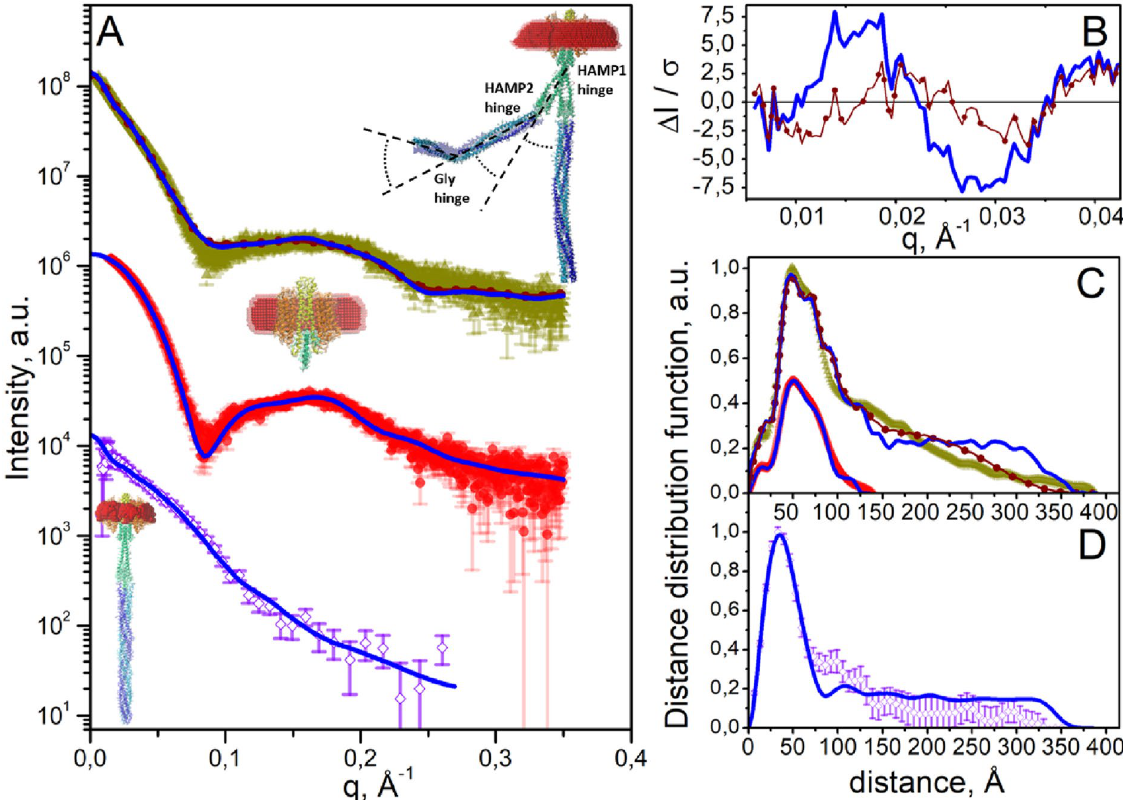
Figure 2. Dimerization of Np SRII/ Np HtrII 137 and of full-length Np SRII/ Np HtrII at low salt concentration. ( A ) Bottom—experimental SANS curve for Np SRII/ Np HtrII (purple hollow rhombus) and CRYSON fit ( χ 2 = 0.7, corresponding blue line) based on a model (shown on the left of the curves) of an Np SRII/ Np HtrII dimer with a detergent corona. Middle—experimental SAXS curve for the Np SRII/ Np HtrII 137 dimer (red circles) and MEMPROT fit ( χ 2 = 1.5, corresponding blue line) based on a model (shown near the corresponding curve) of the Np SRII/ Np HtrII 137 dimer with the detergent corona. Top—experimental SAXS curve for full-length Np SRII/ Np HtrII (dark yellow triangles) and two theoretical approximations. The first (blue solid line) is a CRYSOL3 fit ( χ 2 = 5.1) based on a "straight" model of the Np SRII/ Np HtrII dimer. The second (brown pointed line) is a fit ( χ 2 = 3.4) based on a combination of modified models of the Np SRII/ Np HtrII dimer (see “Methods”, Fig. S2 and Text document S1 for details). While the difference between the two fits is not immediately apparent, the improved fit of the second approximation is evident when considering of the relative residuals of the fit in the region in reciprocal space q < 0.04 Å −1 (see B ), that corresponds to the distances > 160 Å in a real space. For this range of distances, discrepancy between the experimental distance distribution function and theoretical one obtained for the "straight" model of the Np SRII/ Np HtrII dimer is evident (see C ). In the representations of the atomic models, the detergent belt is shown in red. ( B ) Relative residuals of theoretical approximations and experimental SAXS data obtained for full-length Np SRII/ Np HtrII ( A , top). Data related to the "straight" model is shown as blue solid line; data related to the combination of modified models is shown as brown pointed line. ( C ) Distance distribution functions calculated from the SAXS curves shown in ( A ) (designations are the same as in A ). ( D ) Distance distribution functions calculated from SANS data shown in ( A ) (designations are the same as in A dimers, inter-dimer contacts in which are induced both between the transmembrane regions of dimers and their cytoplasmic tips (Fig. 4A), resulted in χ 2 = 5.4 (Fig. 3A). In contrast, fitting the same SANS curve to a theoretical curve based on a mixture of Np SRII/ Np HtrII dimers and "tripod"-shaped trimers of dimers (Fig. 4B) resulted in χ 2 = 1.3 (Fig. 3B). Pair distance distribution function calculated from experimental SANS data obtained at 4.0 M NaCl has two peaks (see Fig. 3C). The position of the first peak (r ~ 30 Å) allows one to interpret it as a peak from dimers, while the position of the second peak (r ~ 100 Å) is in a good agreement with the position of the peak corresponding to the "tripod"-shaped model of the trimer of dimers (see Fig. 3C). The conformation of trimer of dimers of the Np SRII/ Np HtrII SANS experiments at NaCl concentrations 1.4 M and 2.8 M (Fig. S4) produced similar results but indicated an increasing fraction of tripod-style trimers of dimers with increasing salt concentration. Resulting weight fractions of "tripod"-shaped trimers of dimers are 18 ± 3%, 28 ± 2% and 36 ± 2% for 1.4 M, 2.8 M and 4.0 M, respectively (Fig. S5, Table S2). These results support that the formation of Np SRII/ Np HtrII trimers of dimers at high salt concentration is likely to occur through the contacts of the cytoplasmic tips of dimers with their transmembrane parts remaining unconnected (Fig. 4B).